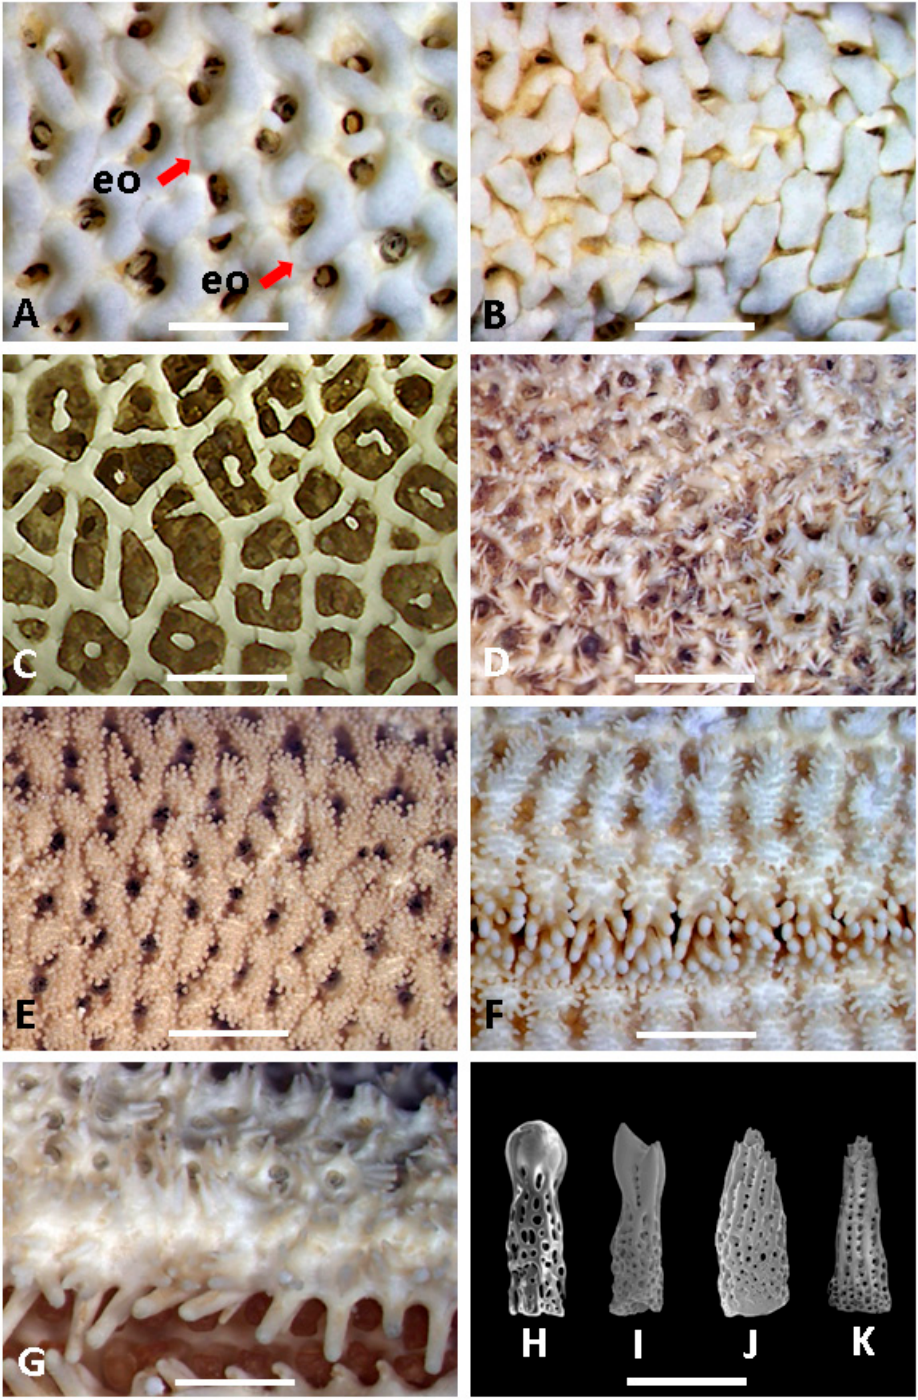
Figure 2. Important morphological characters used in the identification of Korean Henricia species, denuded abactinal skeleton (imbricated), ( A ). H. epiphysialis (eo, extended ossicles), ( B ). H. regularis ; denuded abactinal skeleton (reticulated), ( C ). H. pachyderma ; abactinal paxillae: ( D ). H. anomala , ( E ). H. reniossa ; adambulacral spines: ( F ). H. sanguinolenta (more than 10 spines), ( G ). H. ohshimai (5 or 6 spines); denuded abactinal spines: ( H ). H. leviuscula , ( I ). H. djakonovi , ( J ). H. pachyderma , ( K ). H. perforata . Scale bars: A–G = 1 mm, H–K = 50 µm (SEM images).